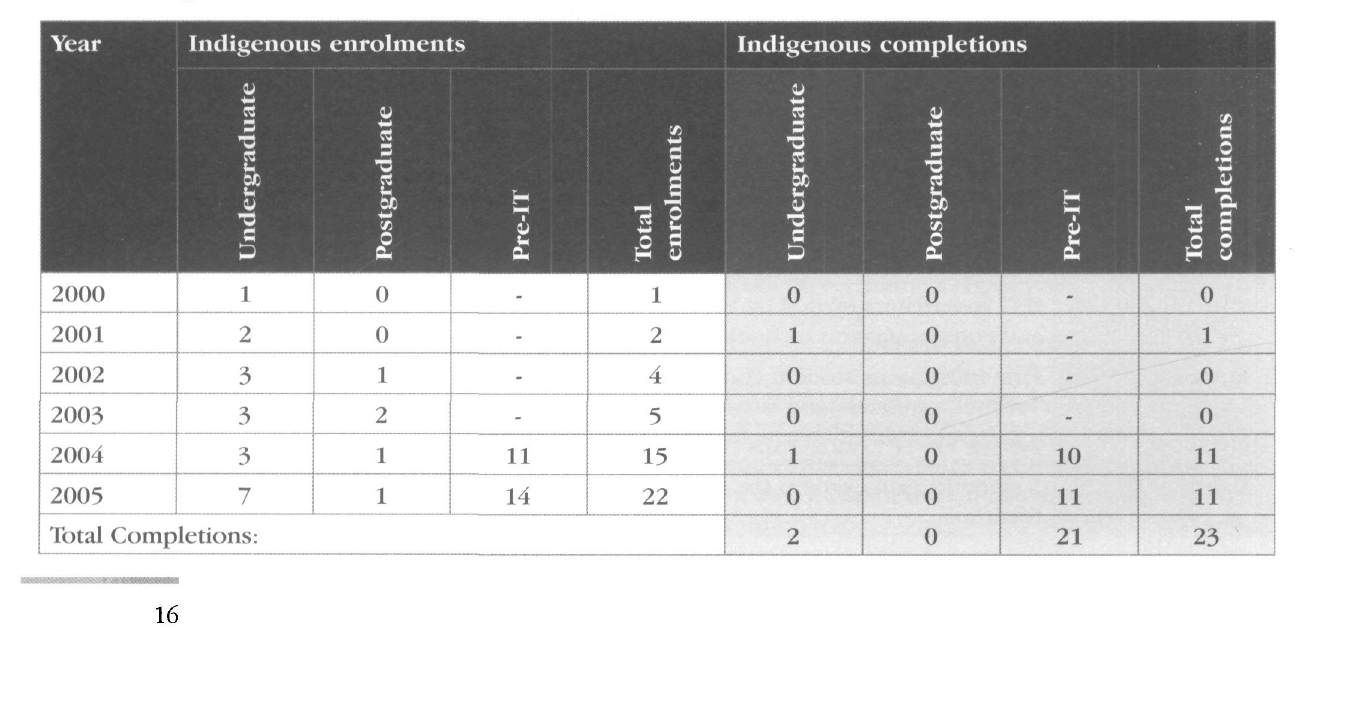
Table 2. Estimated enrolments and completions of Indigenous students in IT programmes at UTS 2000-2005 (Note: Enrolments include newly enrolling as well as re-enrolling